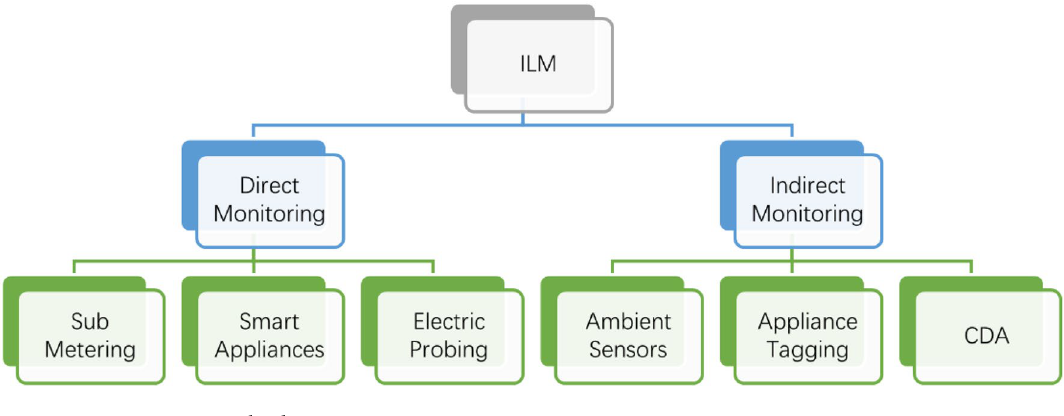
Figure 1. Intrusive load monitoring